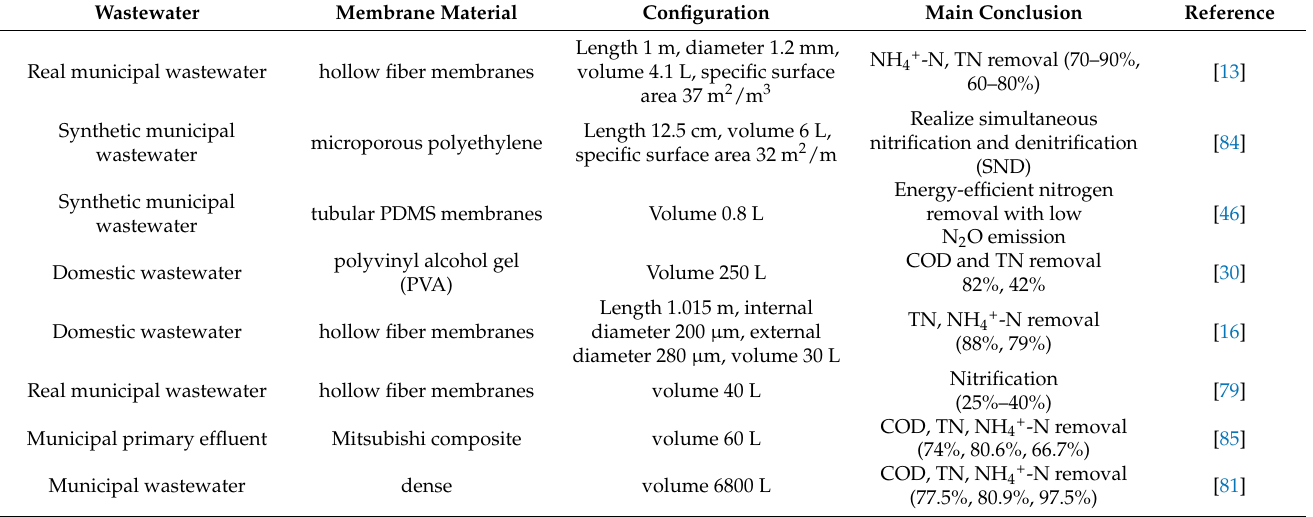
Table 2. Summary of the application of MABR technology in domestic sewage